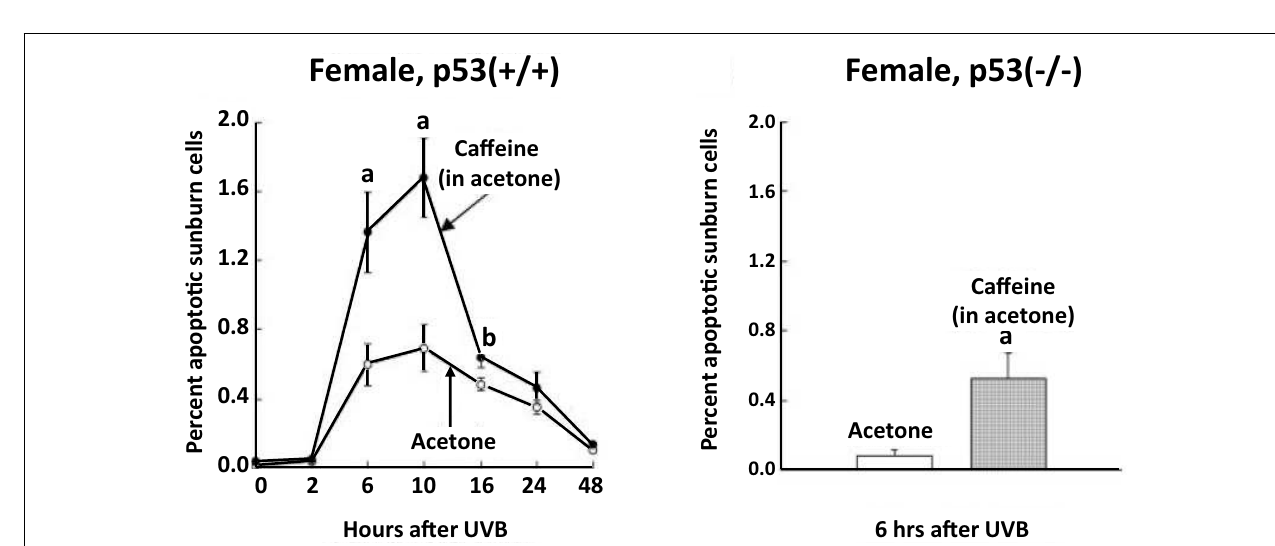
FIGURE 3 | Stimulatory effect of oral administration of green tea or caffeine on UVB-induced increases in p53 positive cells, p21 positive cells, and apoptotic sunburn cells in the epidermis of SKH-1 mice . In (A) , female SKH-1 mice were treated with water ( (cid:3) ) or green tea (6mg of solids/ml; (cid:4) ) as their sole source of drinking fluid for 2weeks.The mice were then treated with UVB (30mJ/cm 2 ) and were killed 10h later. In (B) , female